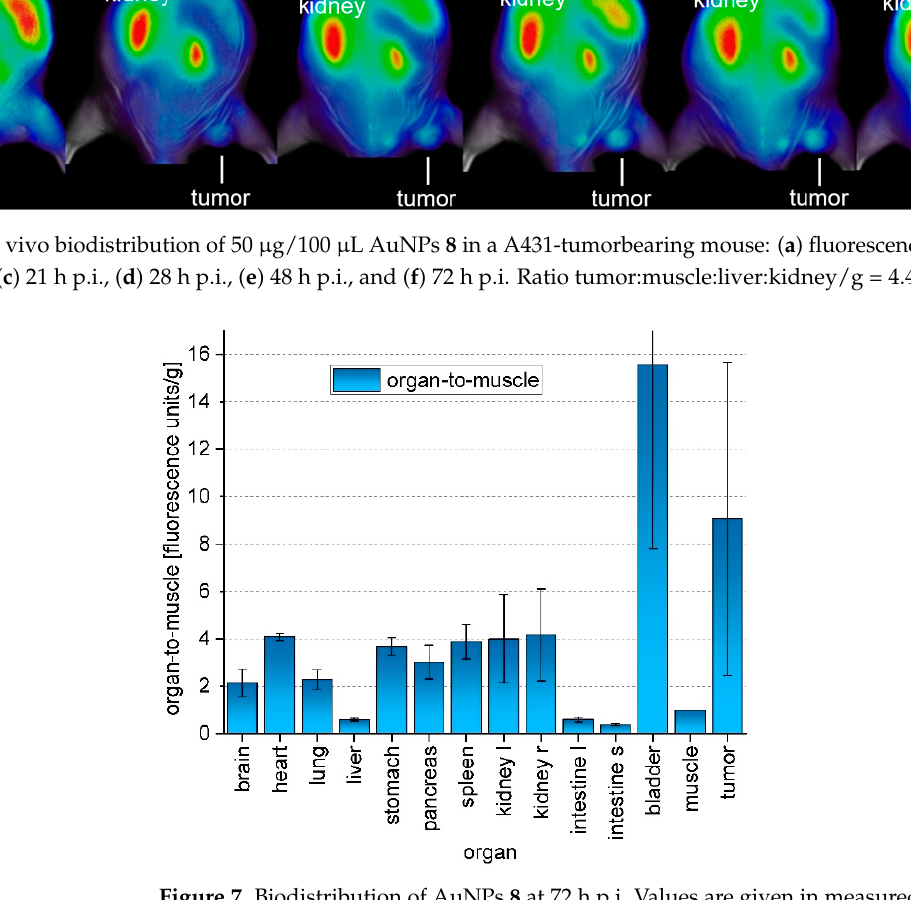
Figure 7. Biodistribution of AuNPs 8 at 72 h p.i. Values are given in measured fluorescence units per organ weight (n = 2).